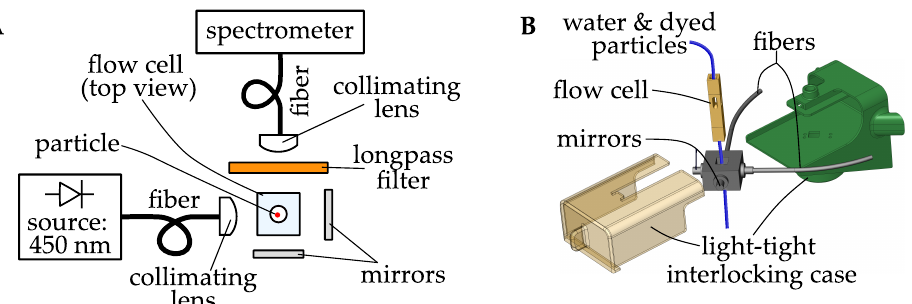
Figure 9. ( A ) An optical system designed to record spectra of NR-dyed particles in suspended in water. Sample water containing NR-dyed MP particles is illuminated by a 450nm light-emitting diode and spectra are continuously recorded with a spectrometer. Spectral analysis can then be performed to determine any detections of MPs and potentially their polymer types. ( B ) The physical implementation of ( A ) is shown. The interlocking case provides portable housing for the